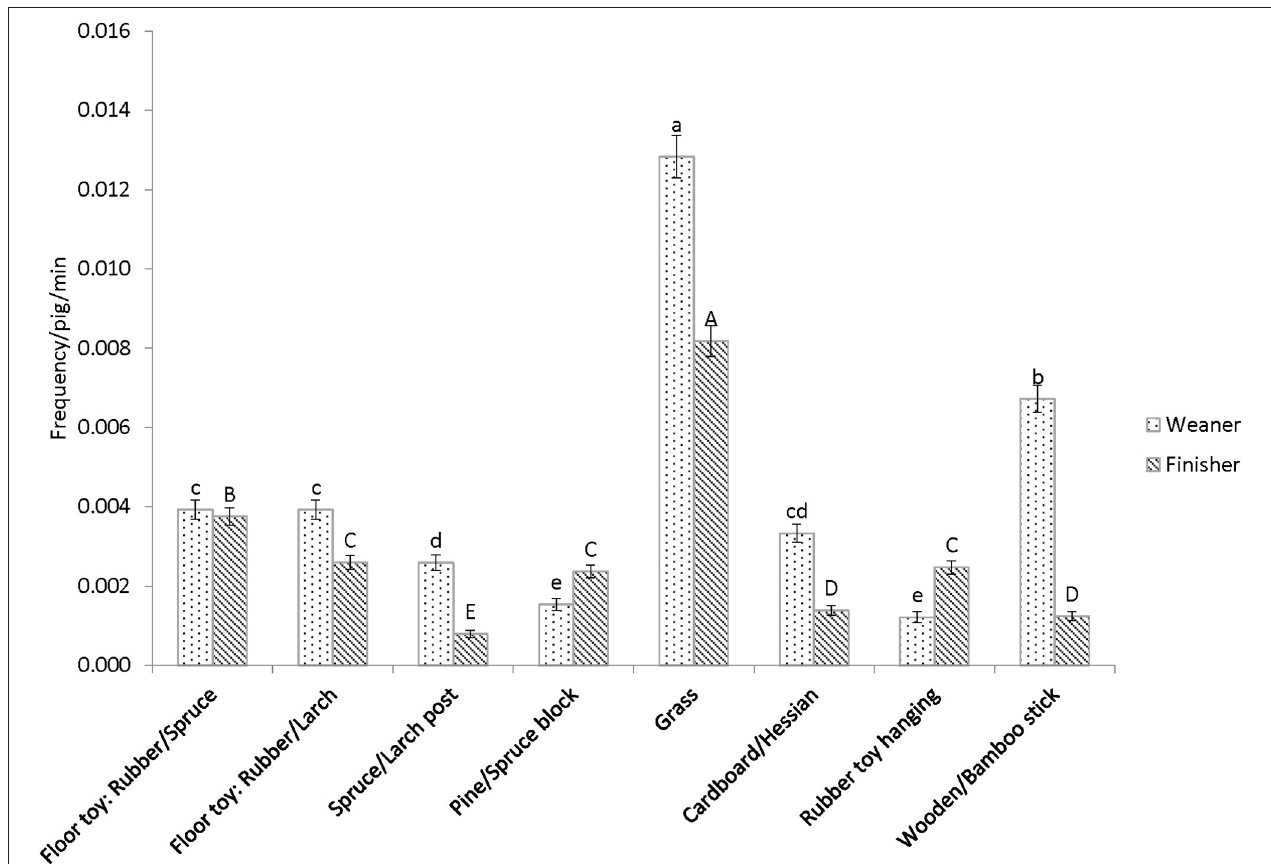
FIGURE 3 | Frequency of interaction by pigs with different items in the weaner and finisher stage. Different small letters denote differences between items in the weaner stage ( P < 0.001), and capital letter for the finisher stage ( P < 0.001), after Tukey-Kramer